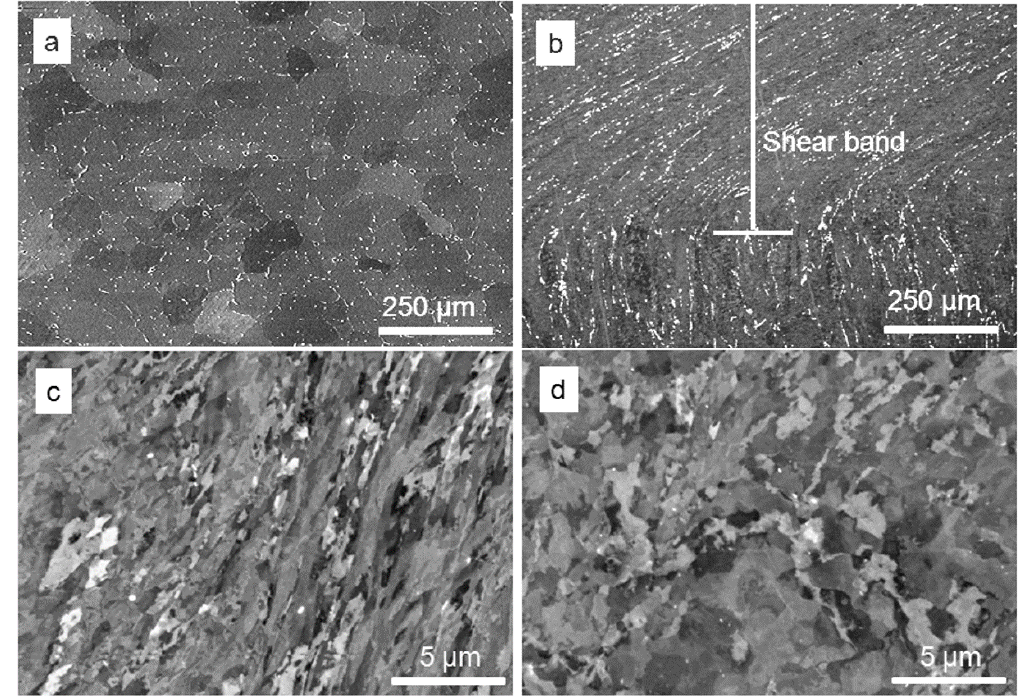
Figure 1. Microstructure of the AlMgSi0.5 alloy in ( a ) cast condition showing constituent particles in the grain boundaries; ( b ) ECAP (equal-channel angular pressing) condition showing shear bands (a part of it is marked by a white bar) introduced into the matrix (below); ( c ) elongated grains in the shear band and ( d ) fairly unchanged grains in the matrix, which is similar to the extruded